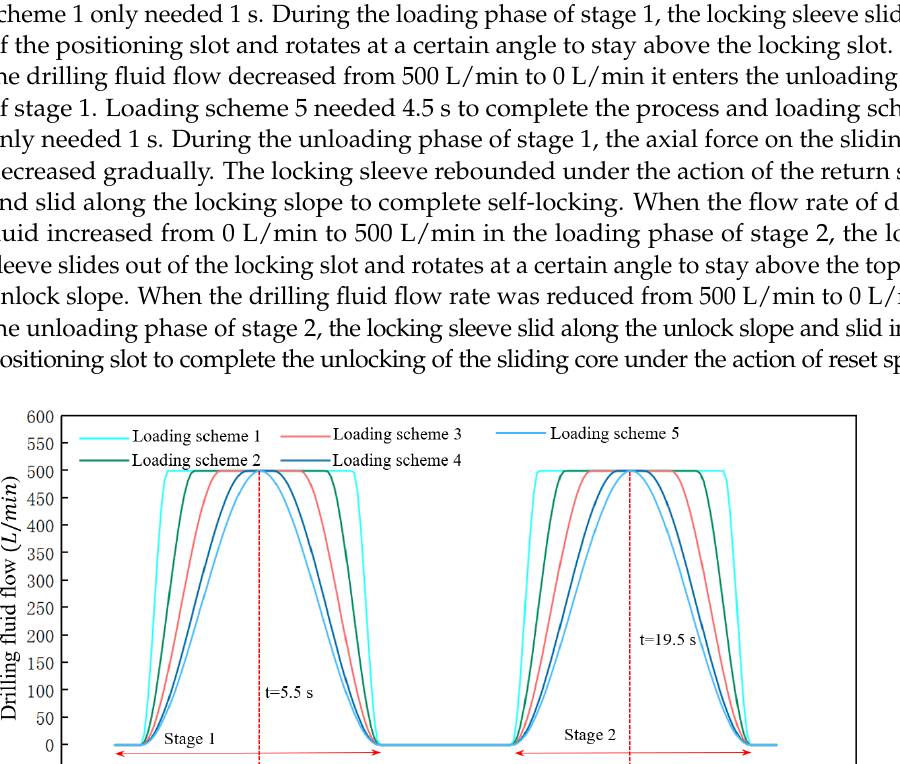
Figure 8. The sliding core velocity laws changes with friction coefficient.